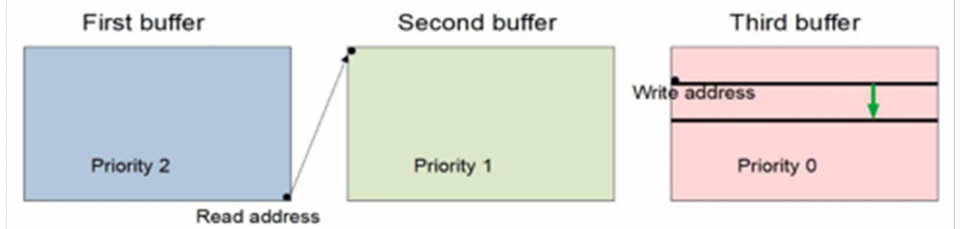
Figure 7. Limit values for buffer change in modified triple